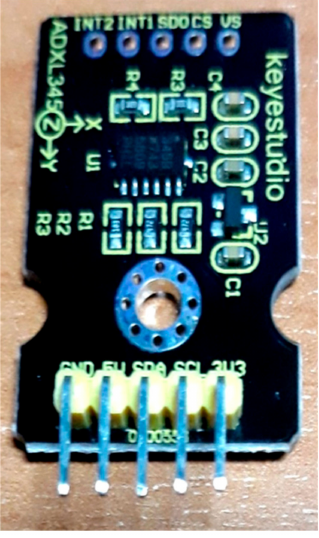
Figure 4. ADXL345